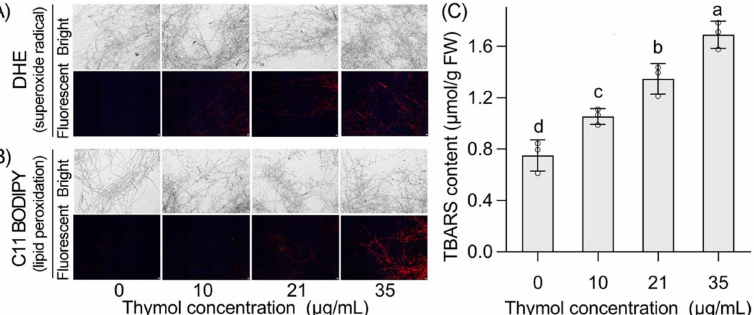
Figure 5. Thymol induced oxidative injury in the mycelia of FON . The mycelia were treated with thymol (0, 10, 21, and 35 µ g/mL) for 24 h. Then the mycelia were collected for ( A ) DHE-based detection of superoxide radical, ( B ) C11 BODIPY-based detection of lipid peroxidation, and ( C ) measurement of TRARS content. Bars in ( C ) indicated SD of three replicates. Different lowercase letters in ( C ) indicated significant difference among different treatments (LSD, n = 3, p < 0.05).